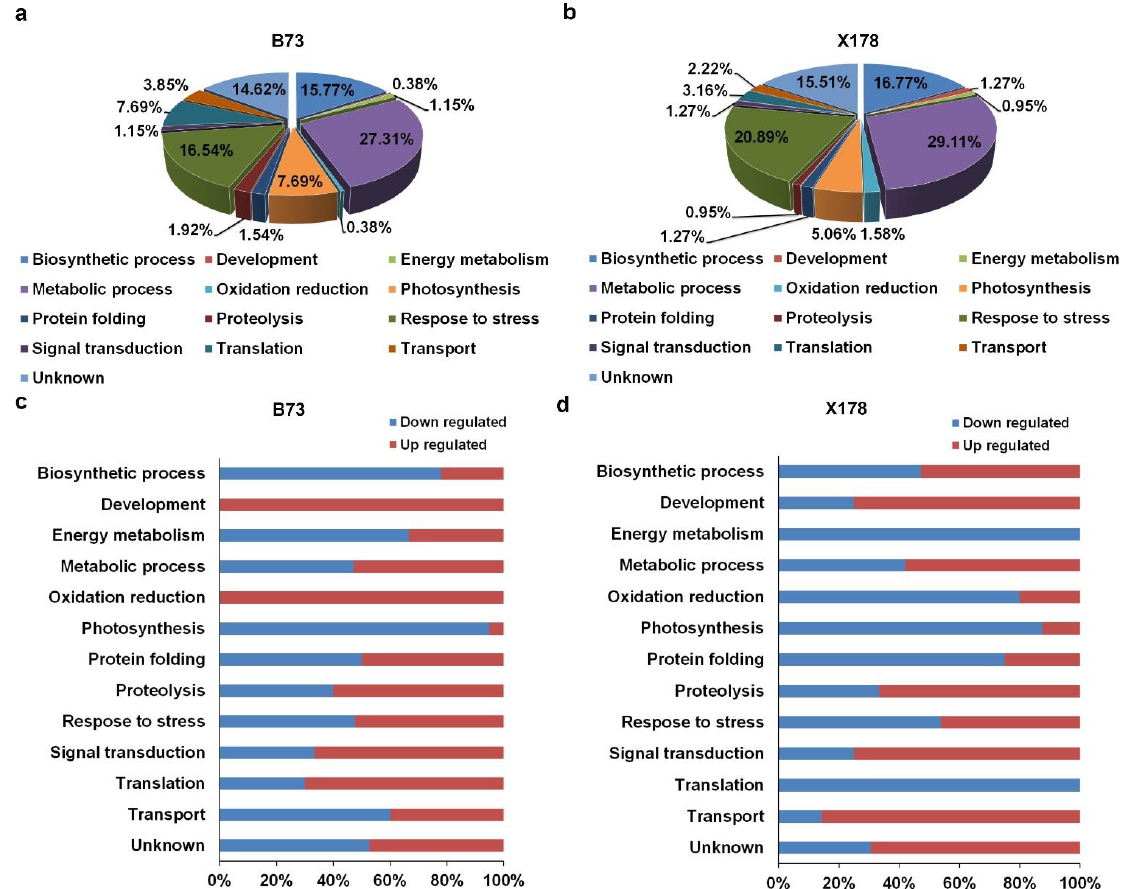
Figure 4. Functional categorizations of DEPs in leaves of maize B73 and X178 plants following RBSDV infection. ( a , b ) Distribution of DEPs in leaves of RBSDV-infected B73 or X178 in different functional categories. ( c , d ) Percentages of up- and down-regulated proteins in leaves of RBSDV-infected B73 or X178 in different functional categories.